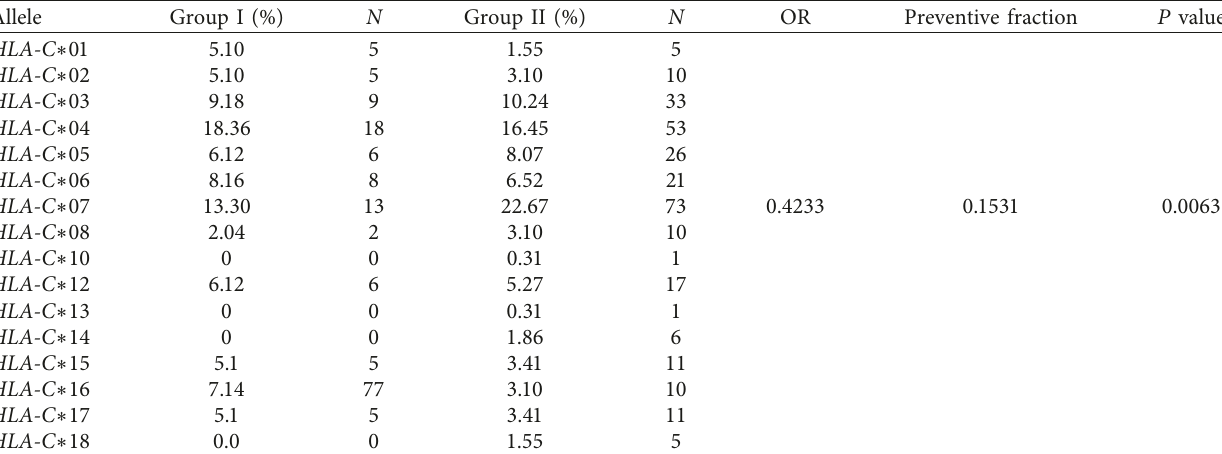
Table 1: HLA-C allele frequencies compared between Groups I (patients with AIDS and CR) and II (patients with AIDS without CR). Allele